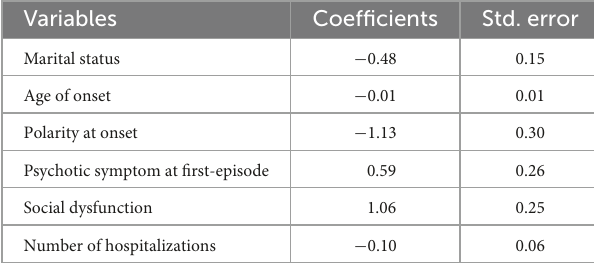
TABLE 2 The estimated coefficients for LASSO regression.